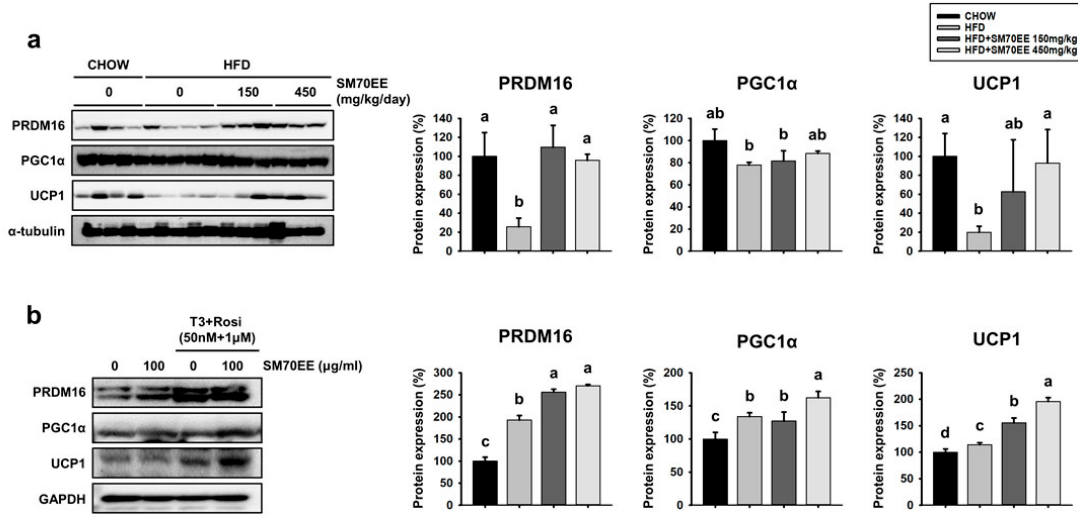
Figure 6. SM70EE administration upregulates thermogenic genes in BAT of HFD-fed mice and in inducible WAT cells. ( a ) BAT from mice treated with SM70EE was analyzed for the expression of BAT-specific proteins. ( b ) SVF cells were differentiated into white adipocytes, as described in the Materials and methods. Protein expression of browning factors was measured in primary WAT adipocytes. All data are presented as mean ± SD ( n = 6). Values with different letters are significantly different, p < 0.05 (a > b > c > d > e).